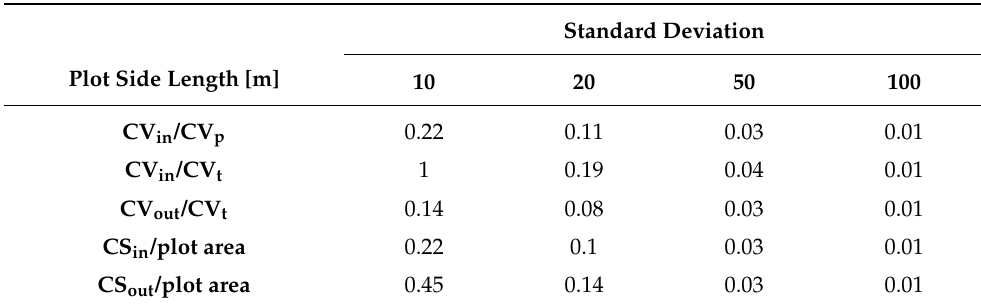
Figure A1. Center positions (black crosses) and footprints of simulated GEDI (black circles) and ICESat (white circles) pulses. The positions were placed at 50-m spacing inside the 50-ha plot. Table A1. Standard deviations of the proportions of the crown volume (CV) and visible canopy surface (CS) for different plot sizes observed in the 50-ha investigation